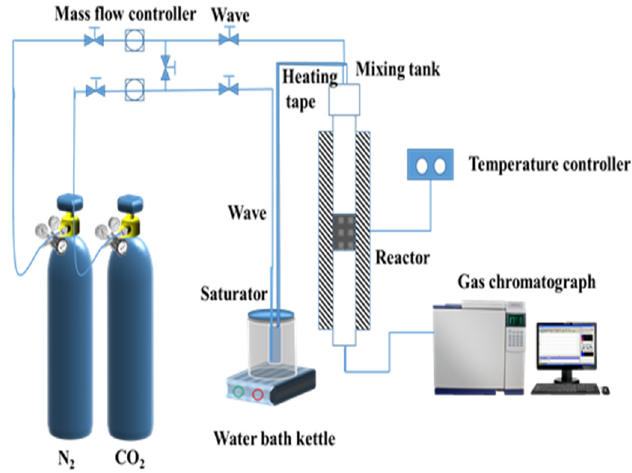
Figure 1. Schematic of CO 2 breakthrough adsorption setup.